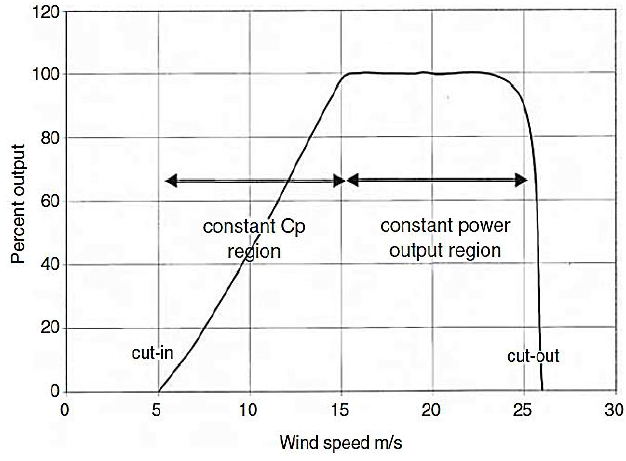
Figure 1. Regions of turbine speed control. Source: [11].